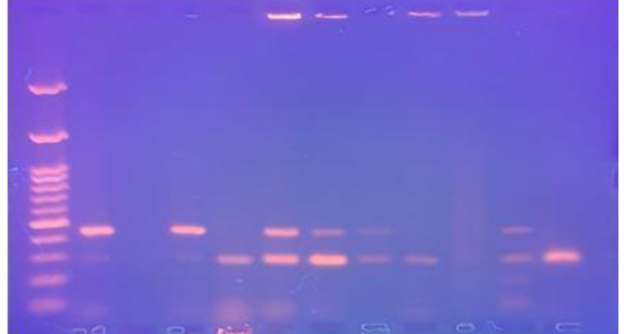
Fig.8; Agarose gel electrophoresis showing amplification of 451 bp fragment for eps A gene using specific primer. Lane 1: 1 kb Ladder, Lanes (2,4,6,7,8,11): positive for Acinetobacter